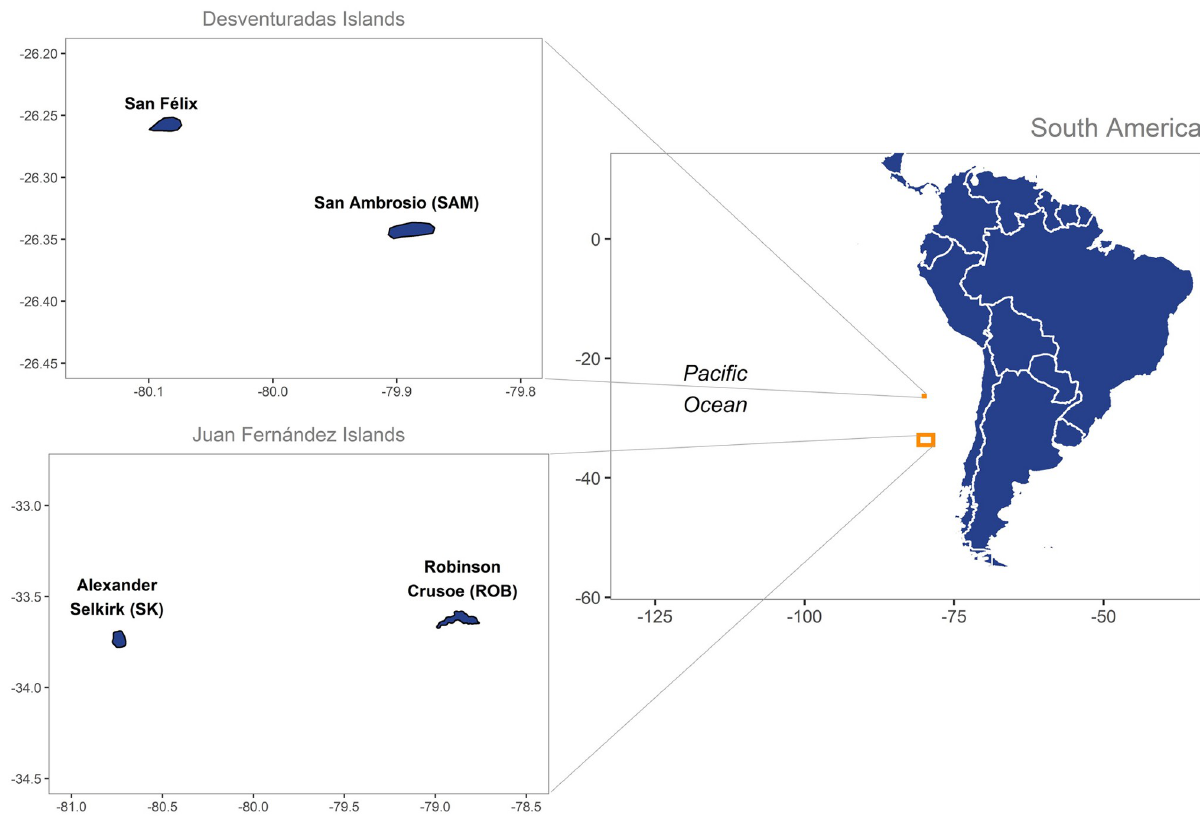
Fig 1. Sampling sites of Centrostephanus sylviae in the Juan Ferna´ndez Archipelago and Desventuradas Island. Red points represent the sampling areas on each island: Robinson Crusoe (33˚36 0 S, 78˚48 0 W), Alejandro Selkirk (33˚48 0 S, 80˚40 0 W) and San Ambrosio (26˚20 0 S, 79˚53 0 W). Maps drawn using library maps [22] and mapdata [23] implemented in R software